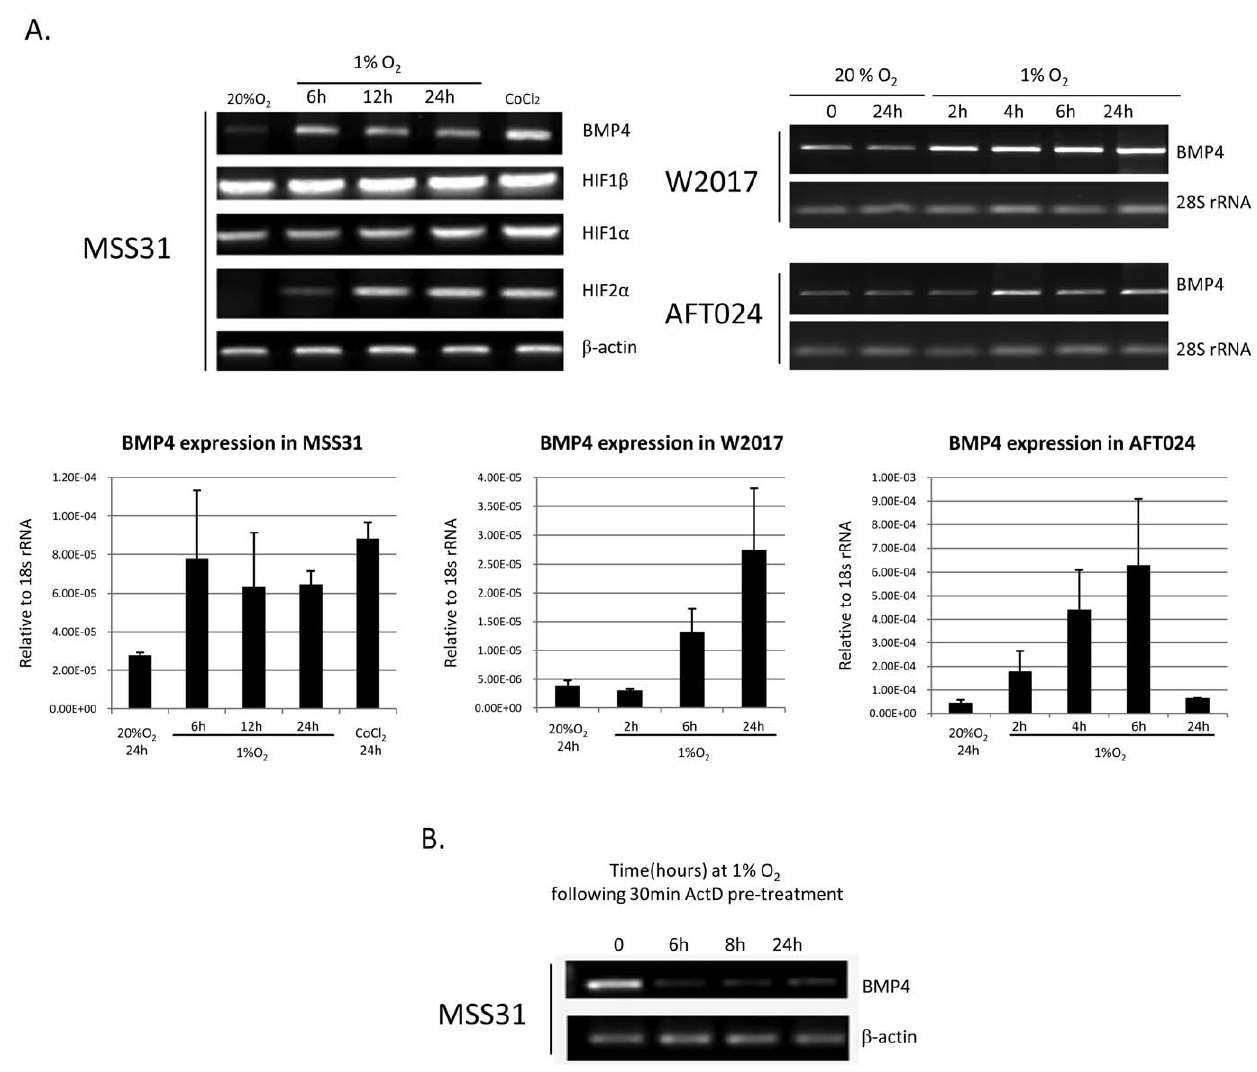
Figure 1. Hypoxia induces the transcription of BMP4. (A) RT-PCR analysis of BMP4, Hif1 a , Hif1 b , Hif2 a or b -actin (control) expression in the MSS31 spleen stromal cell line (top); BMP4 and 28S rRNA (control) in the W2017 osteoblast cell line (middle) and BMP4 and 28S rRNA (control) in the AFT024 fetal liver stromal cell line (bottom) at 20% O 2 or 1% O 2 . BMP4 expression relative to 18S rRNA in these cell lines was also examined by quantitative RT-PCR. (B) MSS31 cells were treated with Actinomycin D (ActD) (1 ug/ml) for 30 minutes prior to shifting the culture to 1% O 2 . At the indicated times cells were harvested, RNA was isolated and the expression of BMP4 was determined by RT-PCR.